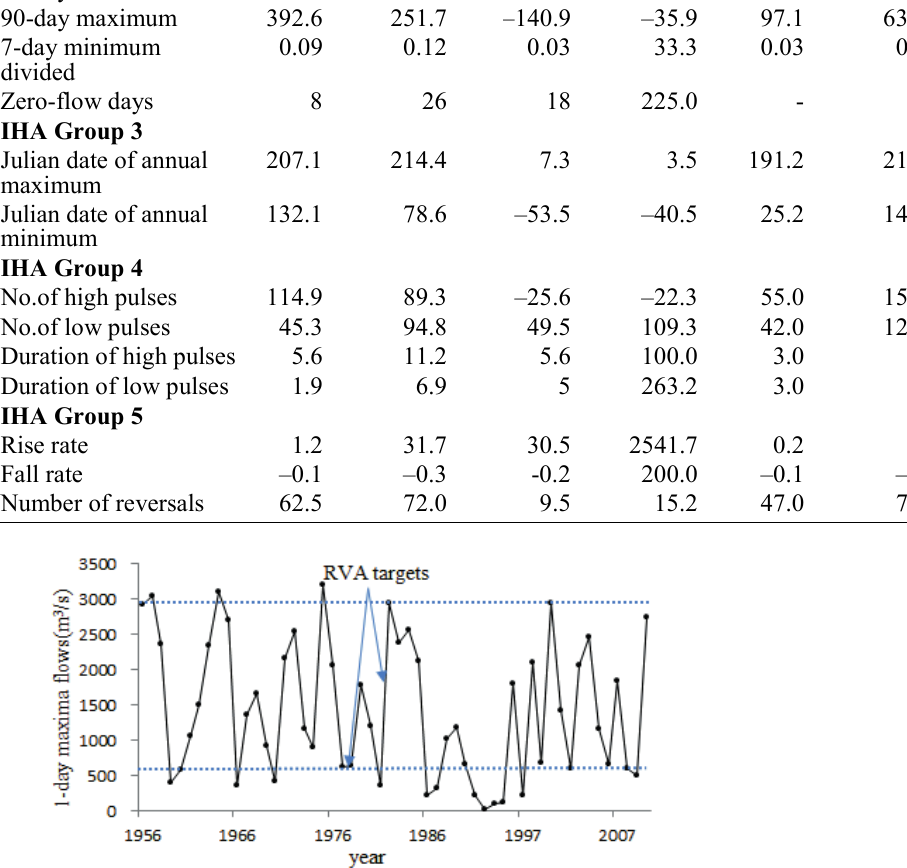
Fig. 3 Variation of 1-day maxima flows pre and